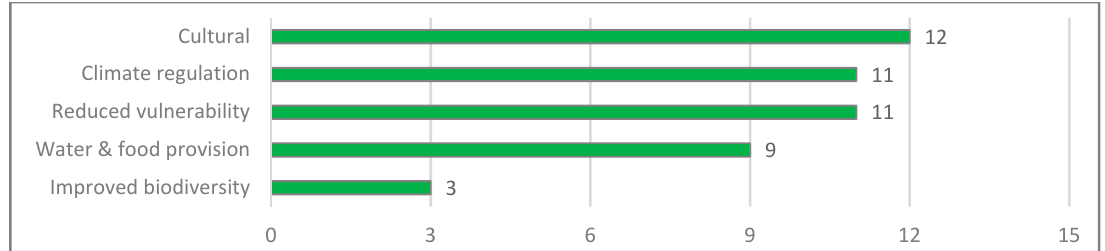
Figure 9. References to ES-related social benefits in the Cartagena case study (own representation).